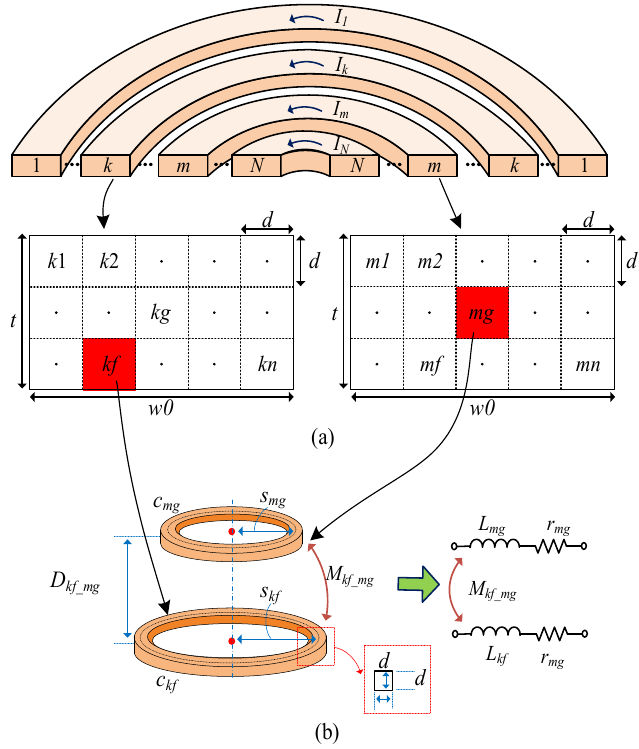
Figure 2. ( a ) Printed concentric circular coils of N loops and cross-section of the k th and m th loops with discretization in the square. ( b ) The f th and g th circular filament loops of the k th and m th circular loops and their equivalent model.